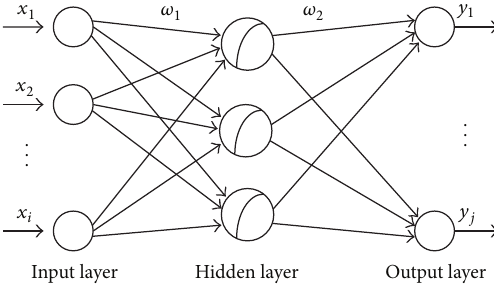
Figure 5: Structure of BP neural